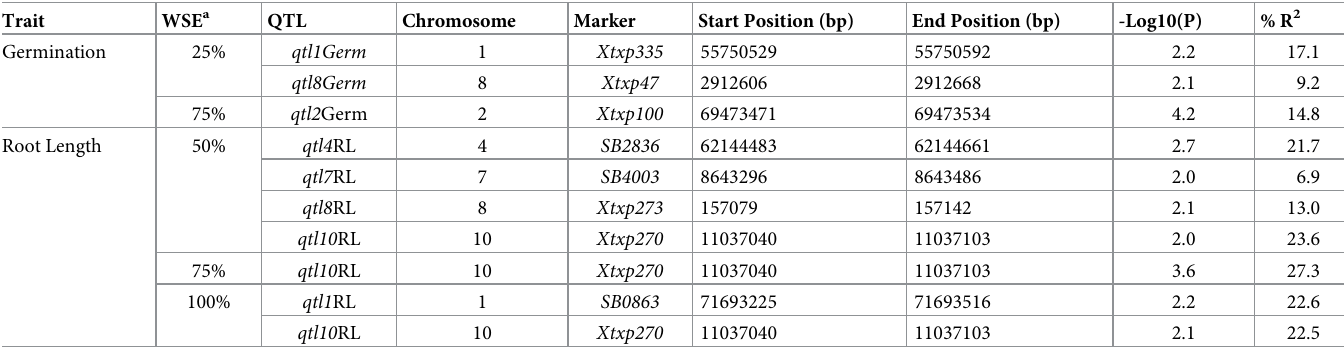
Table 4. QTLs identified by association mapping using Q+K model for the effects of WSE from SDRS on germination and root length growth of lettuce plant.